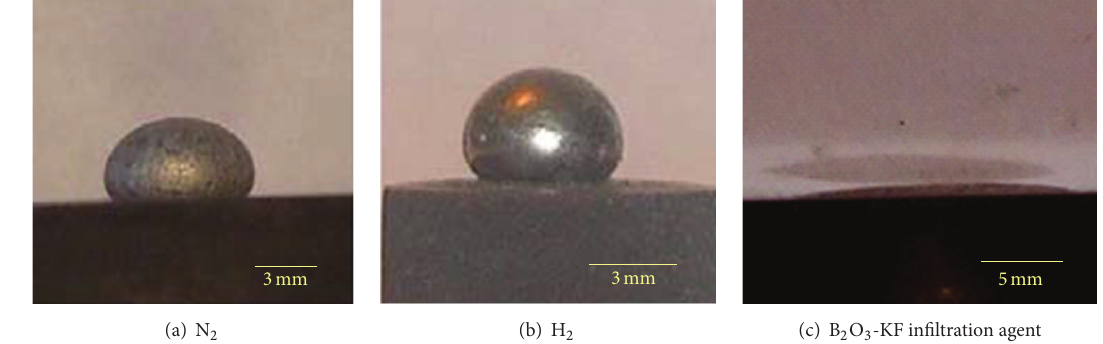
Figure 3: Wetting angle of the soft alloys on the matrix in different